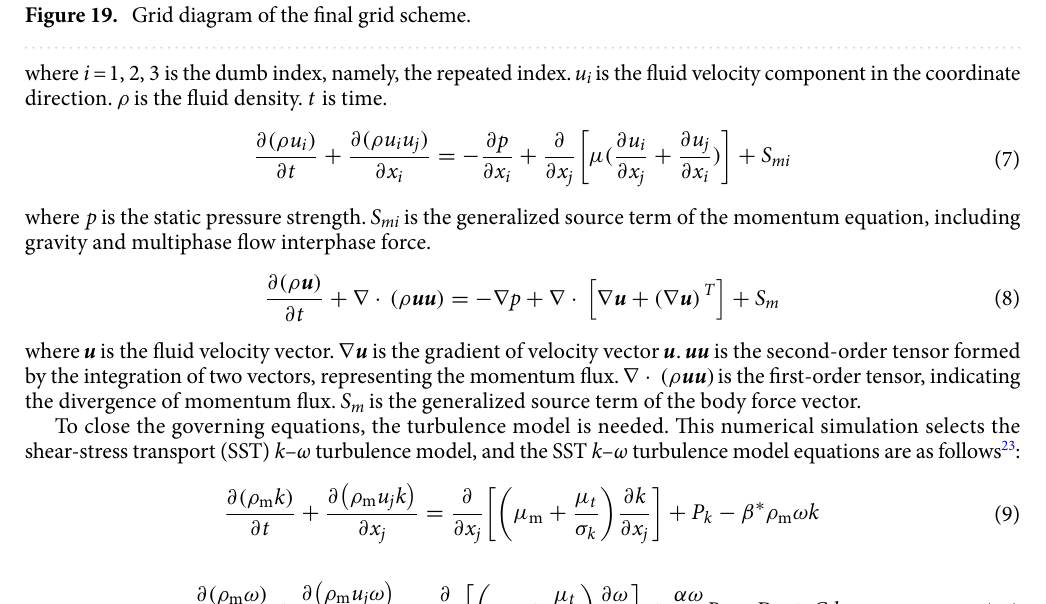
Figure 19. Grid diagram of the final grid